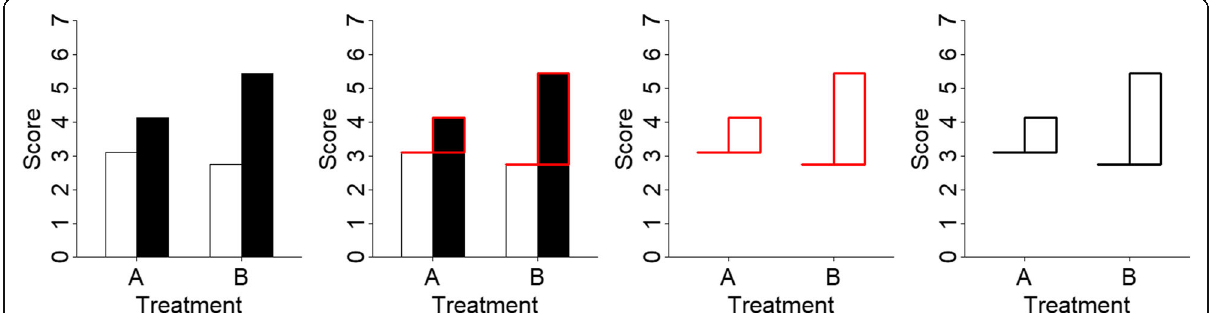
Fig. 1 Illustration of the format of the hat graph as it relates to a bar